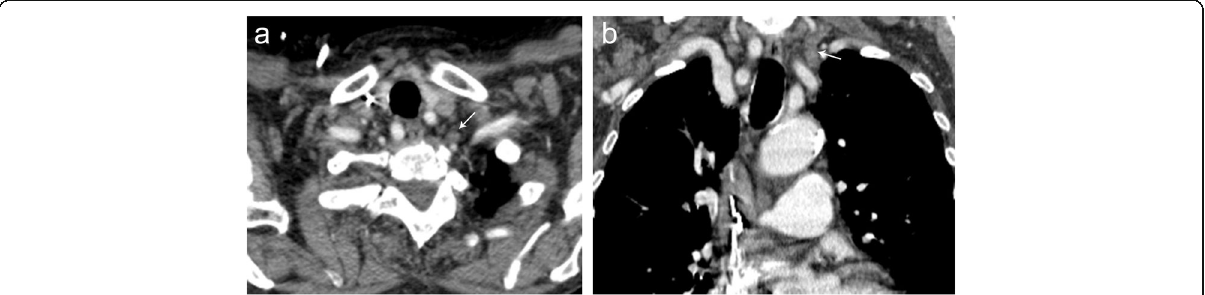
Fig. 20 Dilated thoracic duct. Axial ( a ) and coronal ( b ) contrast CT images demonstrating dilated thoracic duct (arrow) draining into the confluence of the left subclavian and left internal jugular veins. This is considered a normal variant and is important to not mistake it for a pathologic lesion